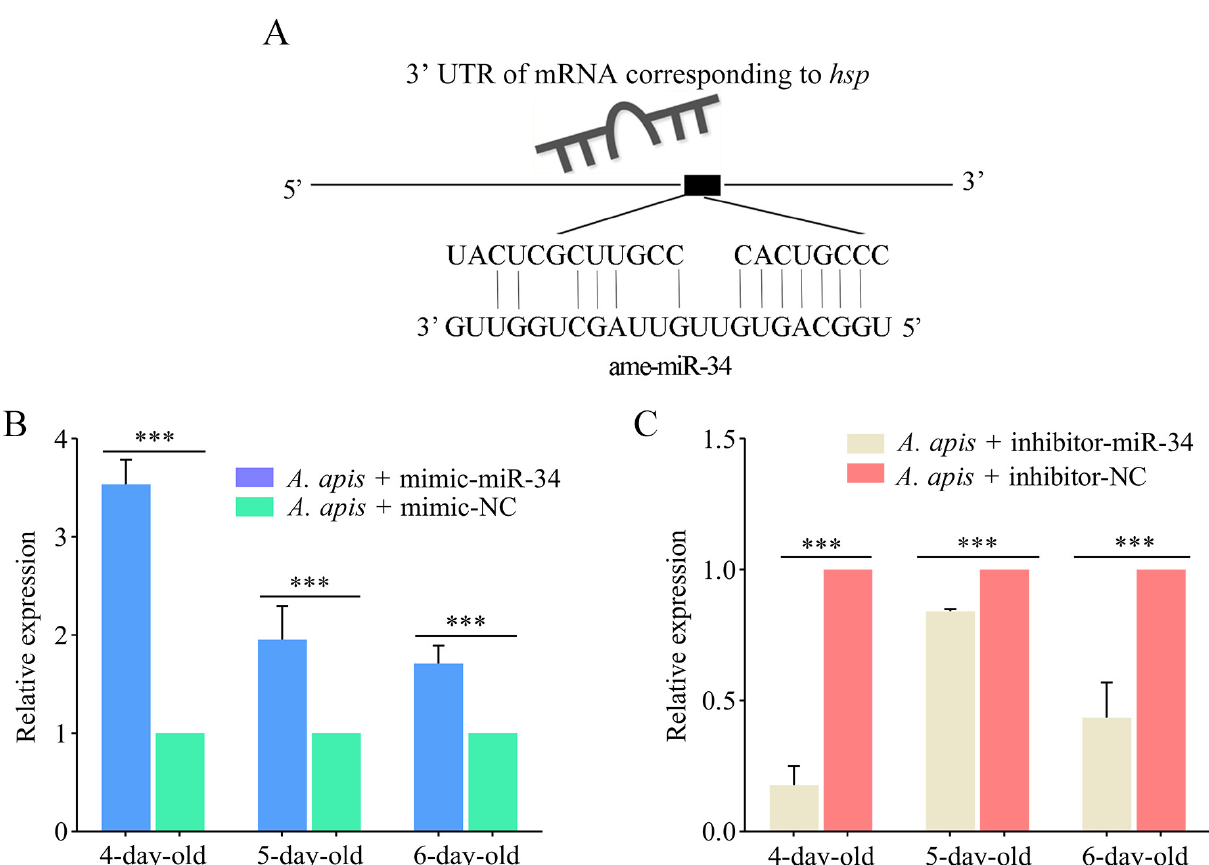
Figure 7. Determination of relative expression level of hsp in the A. apis -infected A. mellifera larval guts after ame-miR-34 overexpression and knockdown. ( A ) Target binding relationship between hsp and ame-miR-34; ( B , C ) RT-qPCR detection of hsp in the 4-, 5-, and 6-day-old larval guts. Data were presented as mean SD and subjected to Student’s t -test, ***: p < 0.001.